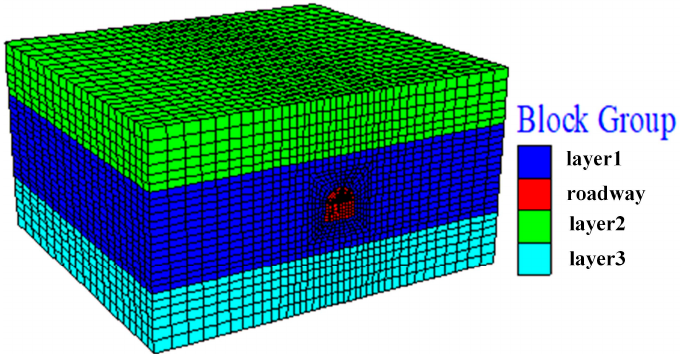
Figure 7. Three-dimensional numerical analysis model.